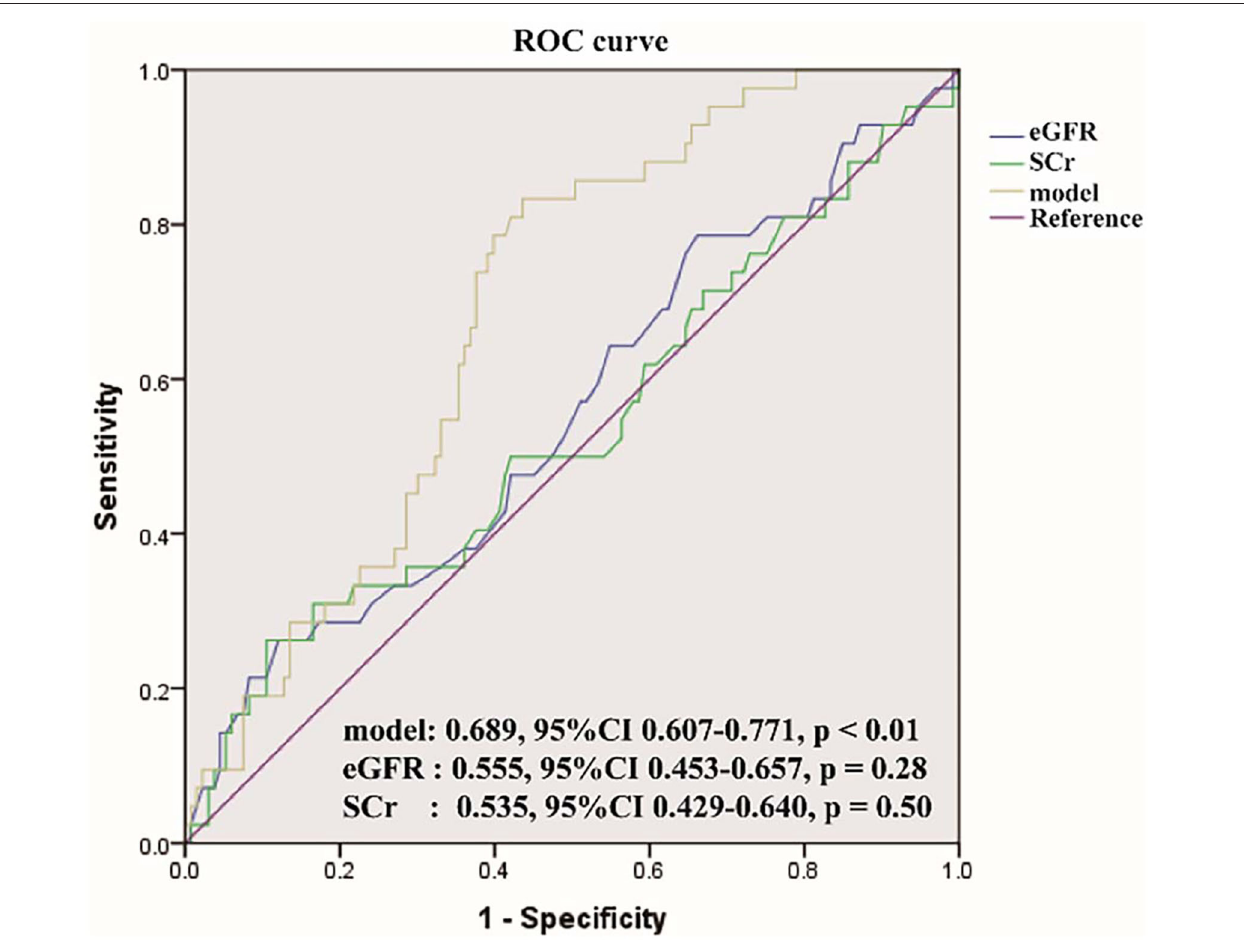
treatment. Another retrospective analysis for identification of BKV infection among living-donor RTRs showed that tacrolimus level and decreased lymphocyte percentage might be the